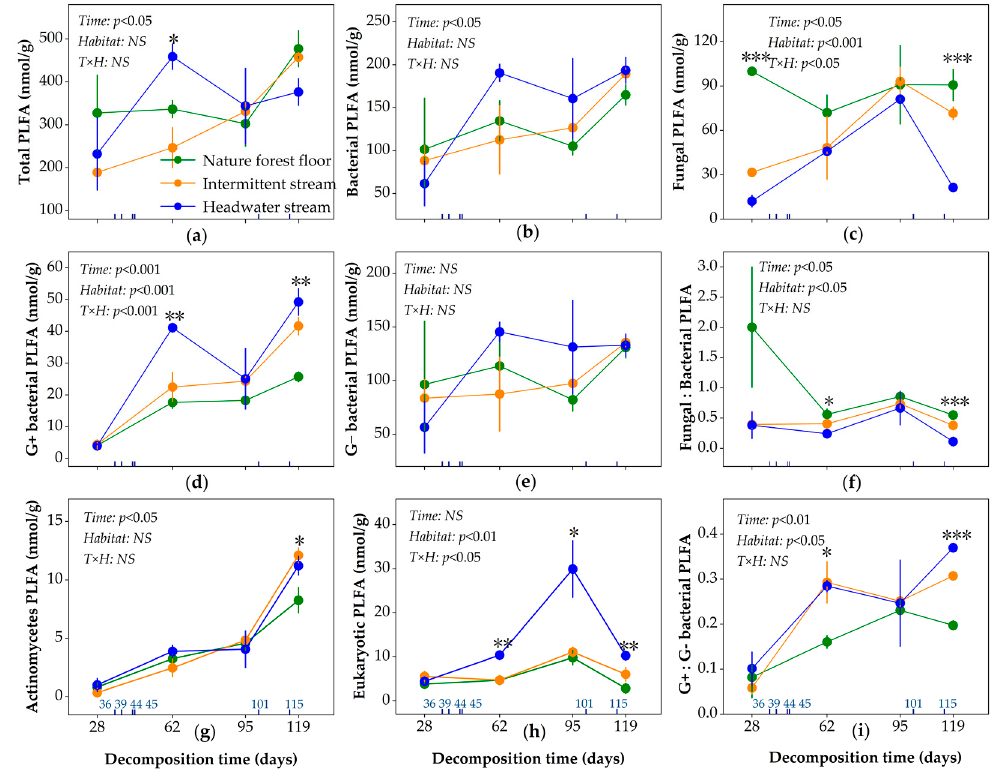
Figure 1. The concentrations of microbial total PLFA ( a ) and PLFA of microbial groups ( b, c, d , e , g , h ) in the natural forest floor, intermittent stream, and headwater stream leaf litter and the ratios of biomarkers ( f , i ). The blue font indicates the number of days the intermittent stream was dry. The p values showed the results from repeated measures ANOVA testing for the effect of habitat type over time. The expression data were shown as mean ± SE. NS : not significant. Asterisks denote significant differences among habitat types: * p < 0.05, ** p < 0.01, *** p <